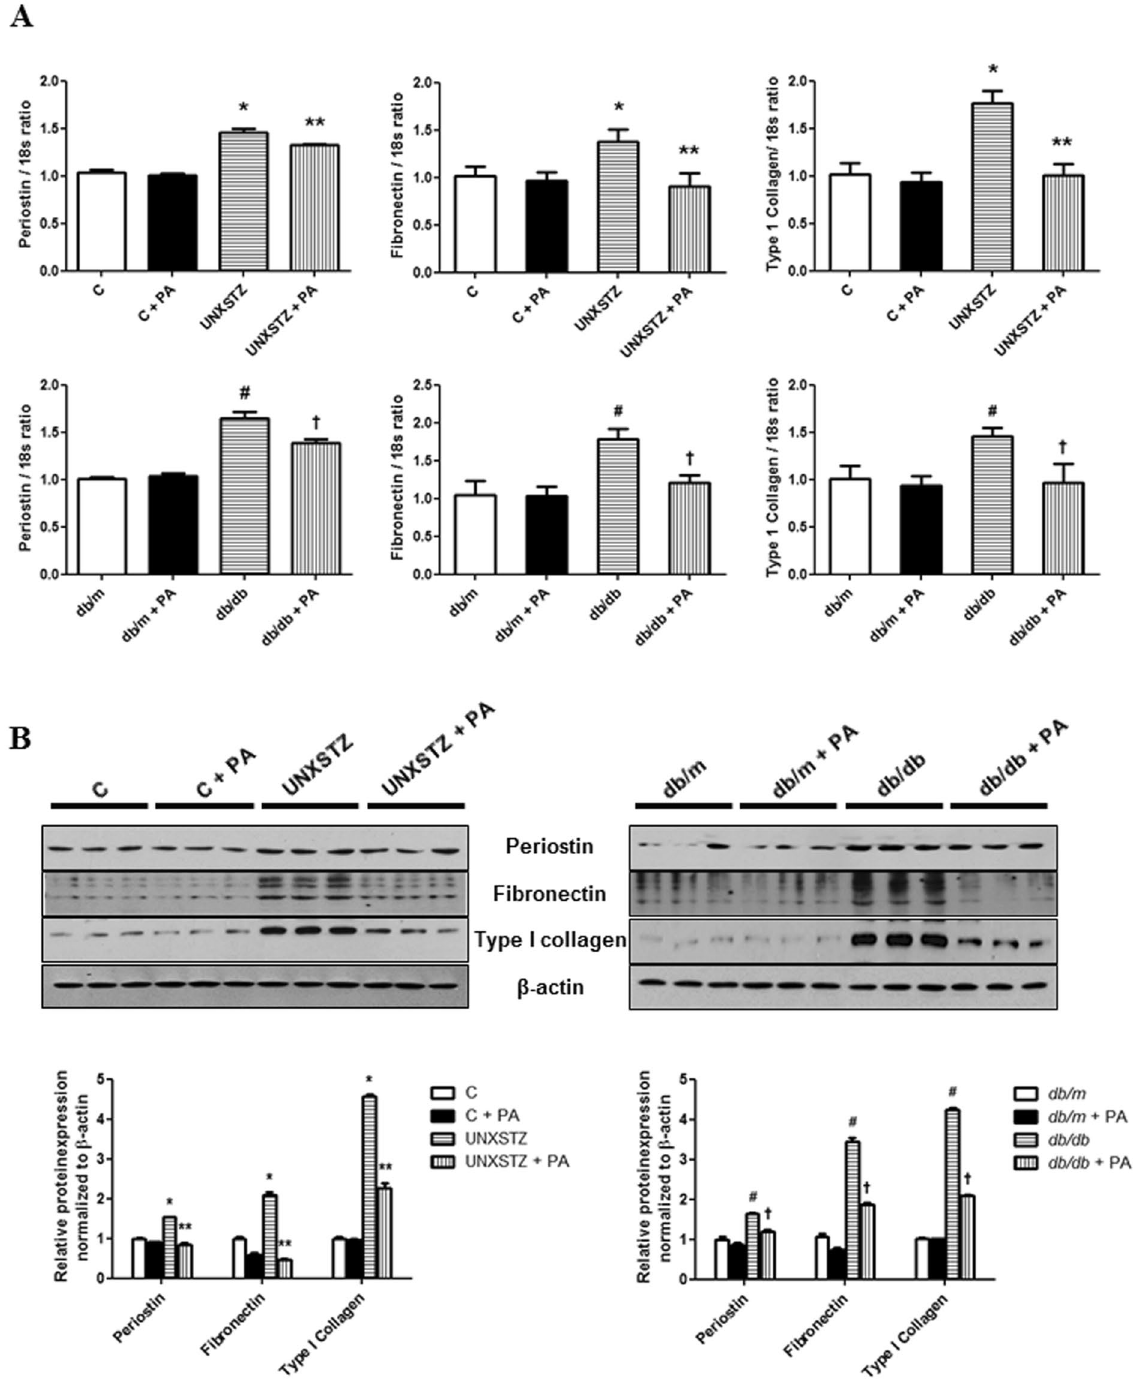
Figure 5. Renal periostin, fibronectin and type I collagen expression in diabetes mellitus (DM) and non-DM mice treated with or without a periostin-binding DNA aptamer (PA). ( A ) Periostin, fibronectin and type I collagen mRNA levels in the kidney (n = 8). Periostin, fibronectin and type I collagen mRNA expressions were significantly increased in uninephrectomized STZ-induced DM (UNXSTZ) and db/db mice compared with the control and db/m mice, respectively. These increases were significantly abrogated by PA administration (500 µ g/kg/d). ( B ) Representative western blotting analysis of periostin, fibronectin, and type I collagen protein levels (a representative of four blots). The protein levels of periostin, fibronectin, and type I collagen were significantly increased in UNXSTZ and db/db mice compared with the control and db/m mice, respectively. The PA treatment significantly ameliorated these increases in the DM mice. Uncropped scans are presented in Supplementary Figure 5. C, control; PA, periostin-binding DNA aptamer; UNXSTX, uninephrectomized STZ- induced DM mice. * P < 0.05 vs. C; ** P < 0.05 vs. UNXSTX; # P < 0.05 vs. db/m ; † P < 0.05 vs. db/db